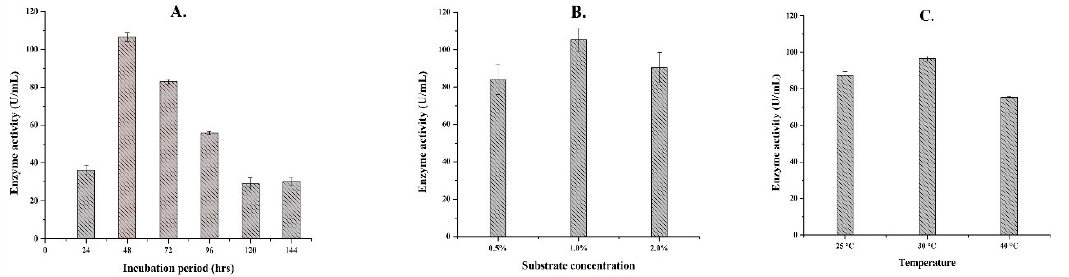
Figure 2. Optimization of the fermentation conditions for maximum enzyme production from strain Aspergillus spp. Gm. ( A ), e ff ect of incubation period; ( B ), e ff ect of substrate concentration; and ( C ), e ff ect of temperature on enzyme production.